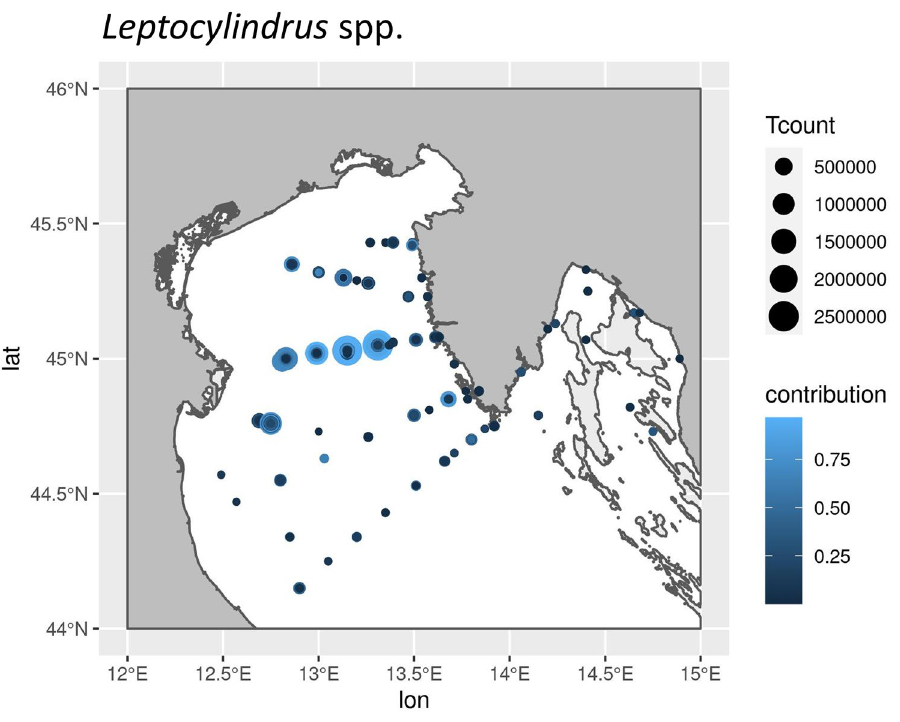
Figure 4. Spatial distribution of Leptocylindrus spp in the northern Adriatic. The area of the circles marking the sampling positions represents the maximum abundance recorded for the position. The shade indicates the contribution relative to the total microphytoplankton abundances at sampling time.